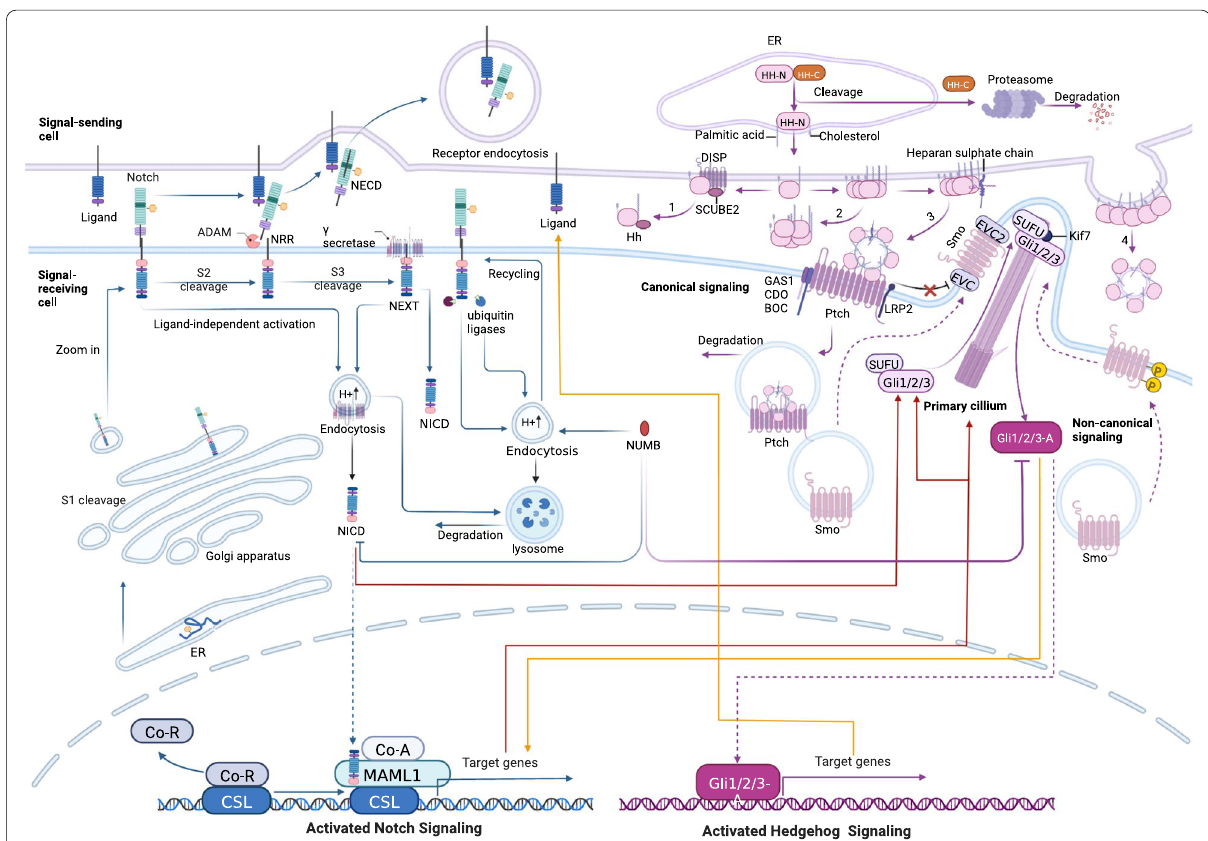
Fig. 1 Overview of the Notch and Hedgehog signaling pathways. The blue arrows on the left side of the figure demonstrate the synthesis, modification, transfer and activation of Notch receptor precursors. The purple arrow on the right shows Hh ligand precursor synthesis, modification and translocation, and activation effect of Hh receptors. Crosstalk in the Hh and Notch signaling pathways is shown by red and yellow